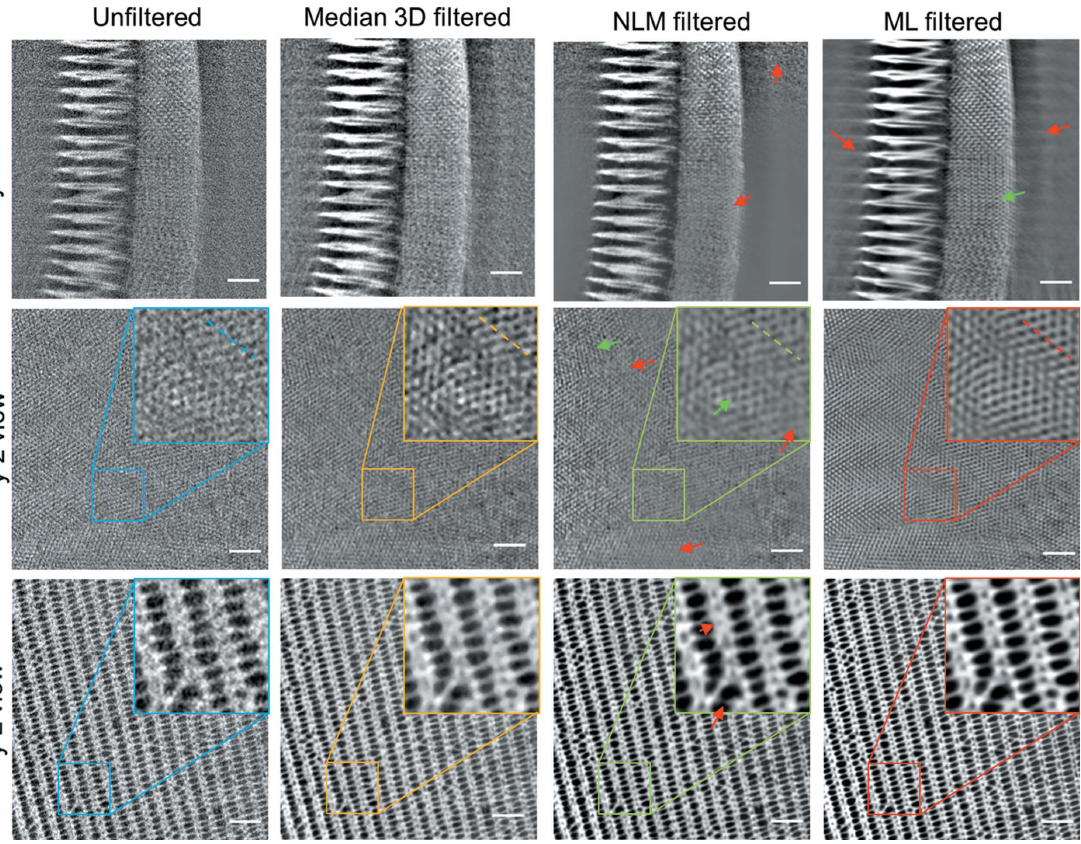
Figure 4 Comparison of the original data set (left) and three filtered data sets of the butterfly scale in an xy view and two different yz views. The filtered data sets are median 3D filtered (2nd column), iterative nonlocal means (NLM) filtered (3rd column) and ML-based filtered (4th column). The scale bars are 2 m